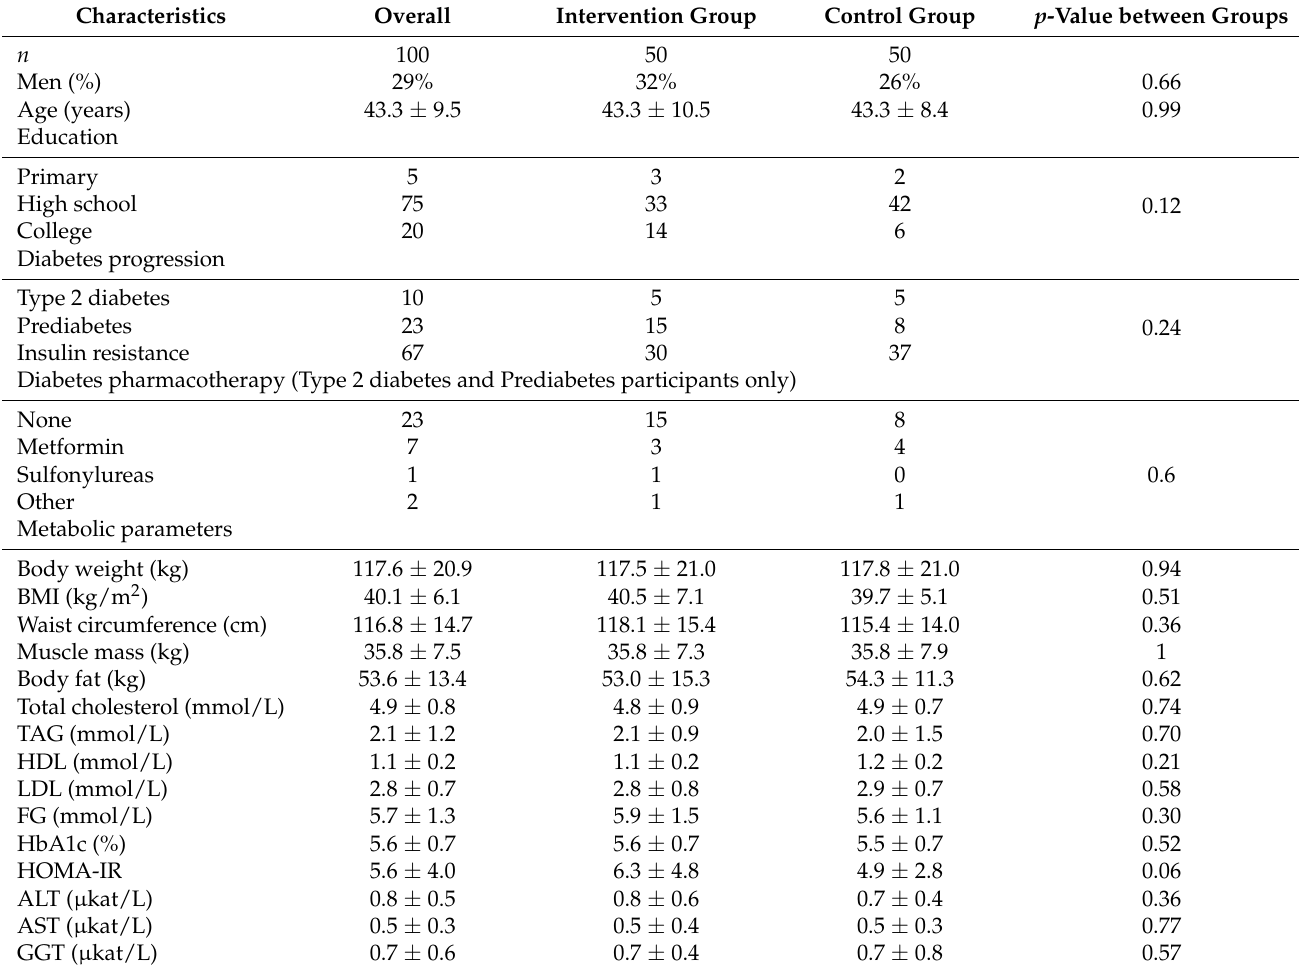
Table 2. Baseline demographic and clinical